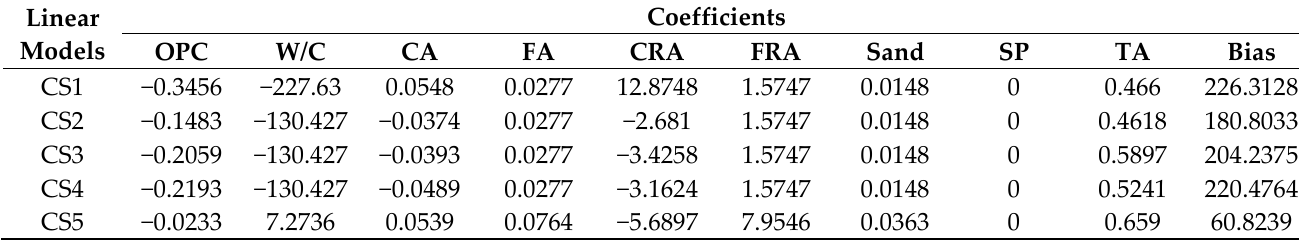
Table A1. Calculated coefficient for the M5P